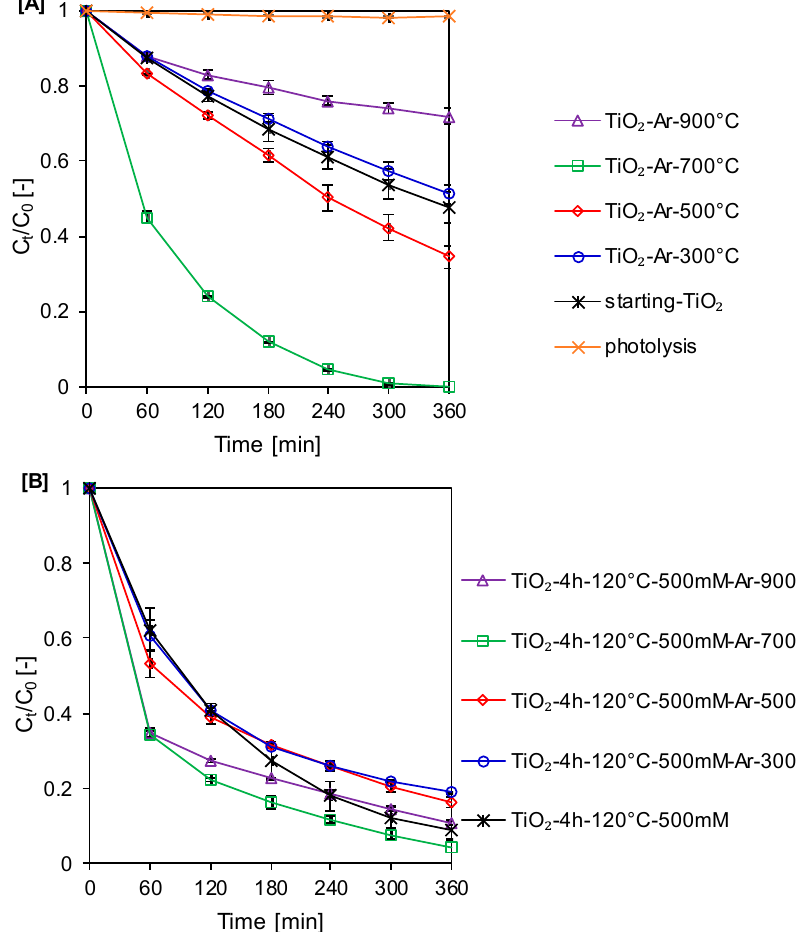
Figure 7. Methylene blue decomposition under UV irradiation for starting TiO 2 and calcined reference samples ( A ), and APTES-modified TiO 2 before and after calcination ( B